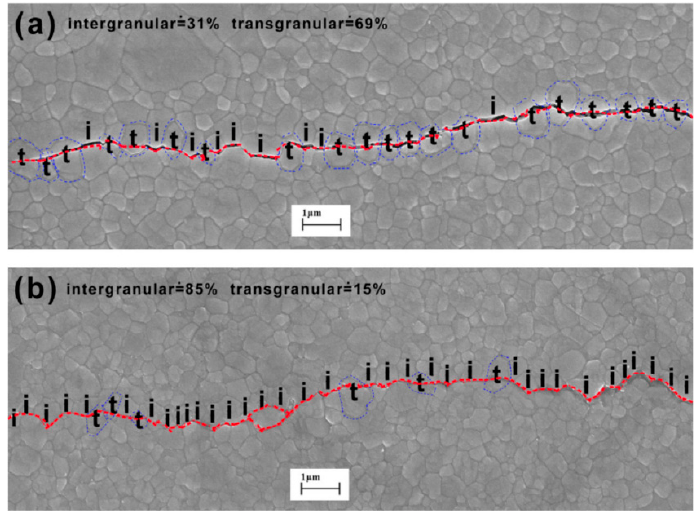
Figure 21. Crack path induced by indentation on the surface of yttria-stabilized zirconia at ( a ) 293 K and ( b ) 77 K [78].